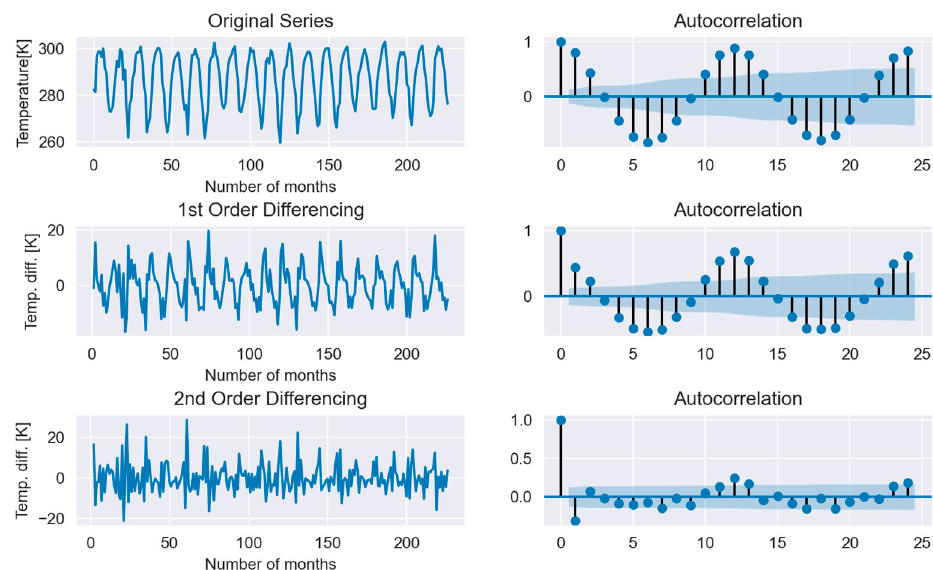
Figure 7. Original data series along with first and second differencing with autocorrelation. The time unit for x-axis is the number of months since the first data acquisition. Final-day temperature of each month is represented.